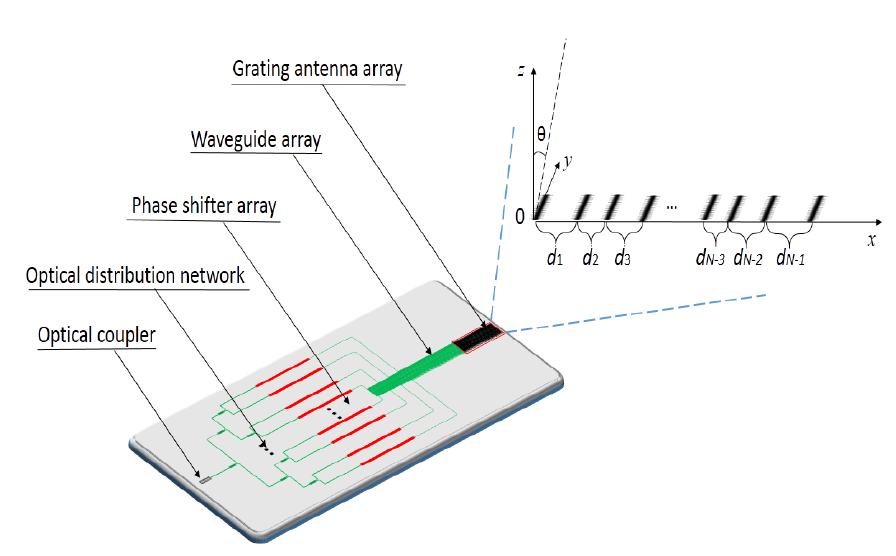
Figure 1. Schematic diagram of optical phased array (OPA).